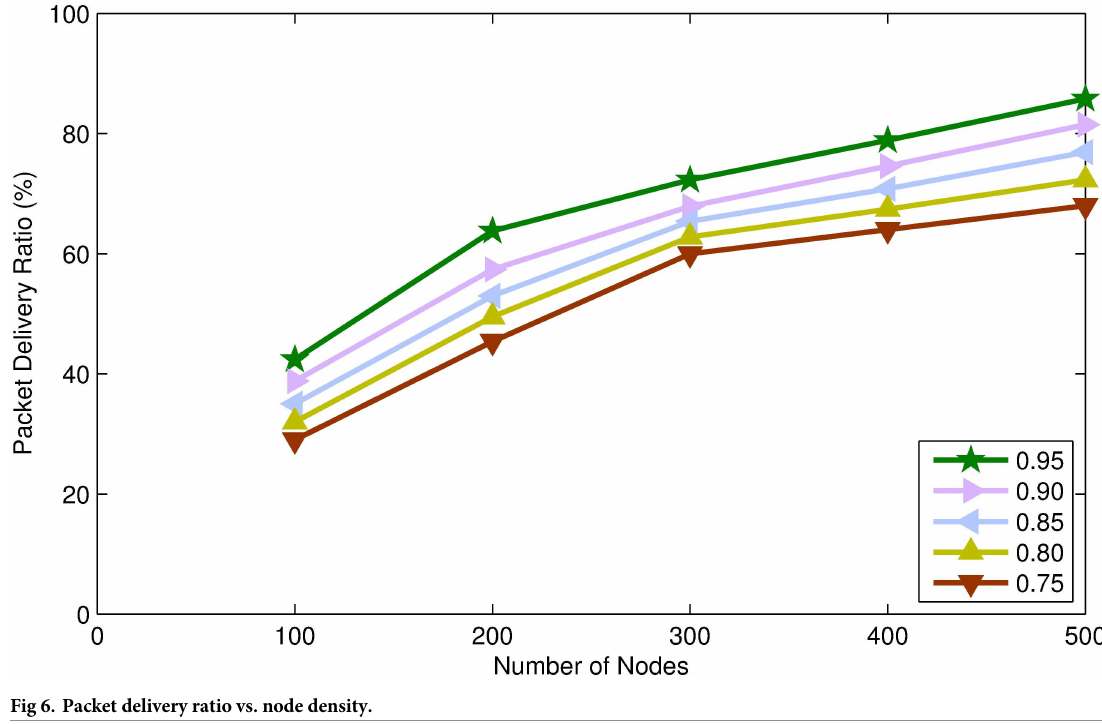
Fig 6. Packet delivery ratio vs. node density.